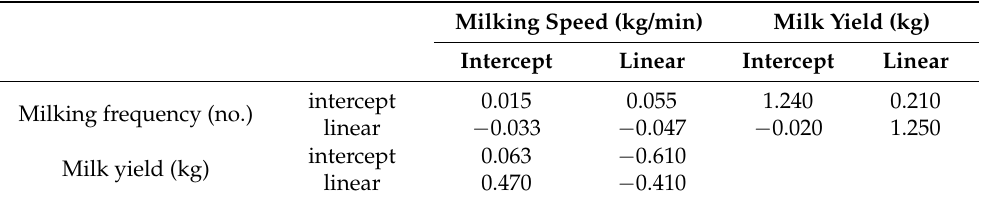
Table 5. Estimates of additive genetic covariance between random regression coefficients in two-trait random regression analysis. Milking Speed (kg/min) Milk Yield (kg) Intercept Linear Intercept Linear intercept 0.015 0.055 Milking frequency (no.)